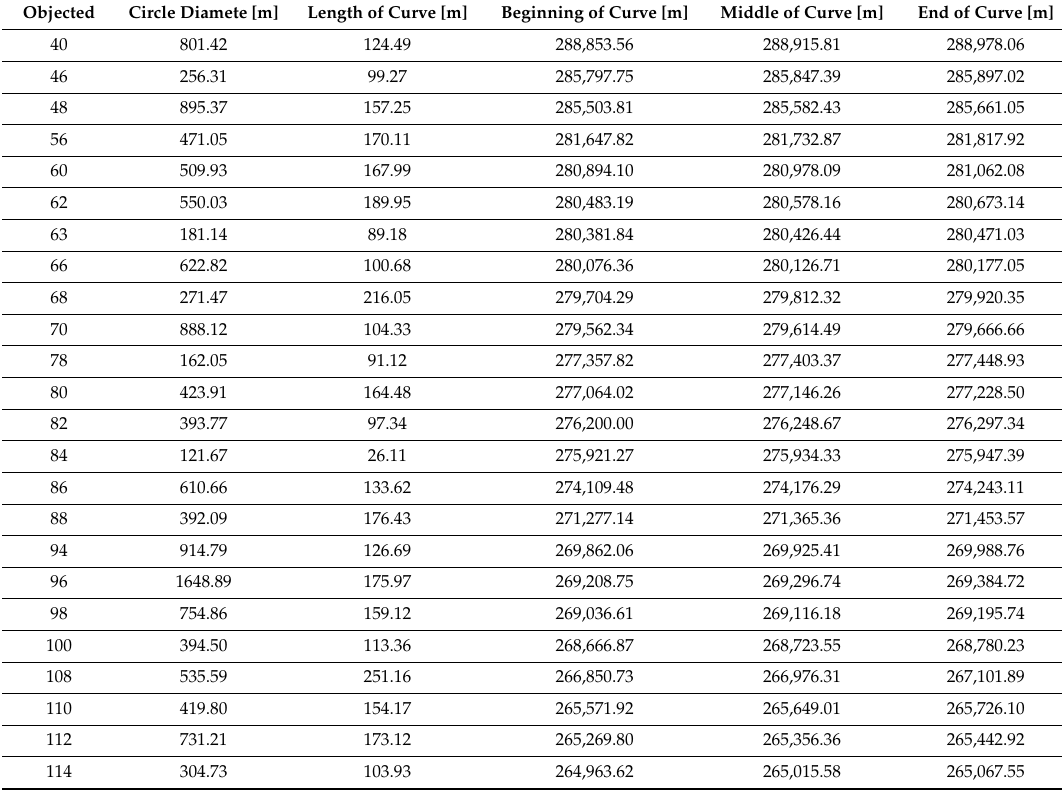
Table 1. Data characterizing segments of road curves.